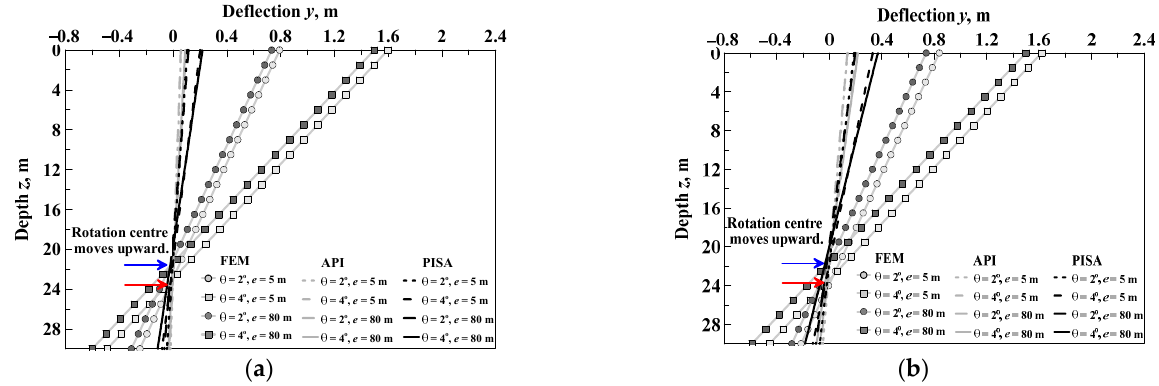
Figure 7. Pile deflection profiles under typical rotations and loading eccentricity in 65% relative density sand: ( a ) D = 4 m, ( b ) D = 10 m.